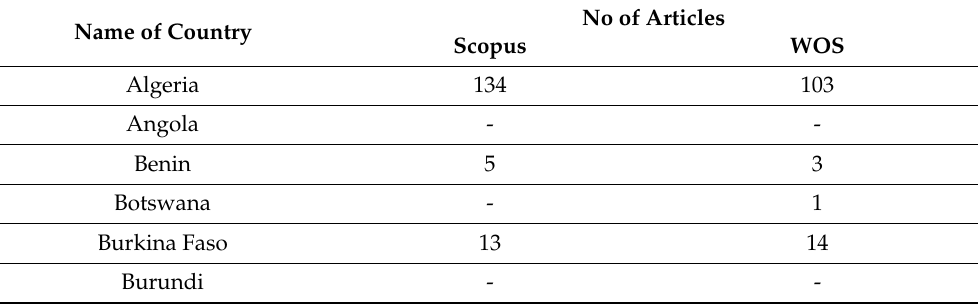
Table A1. The number of “thermal comfort” documents including “name of the country” in SCOPUS and